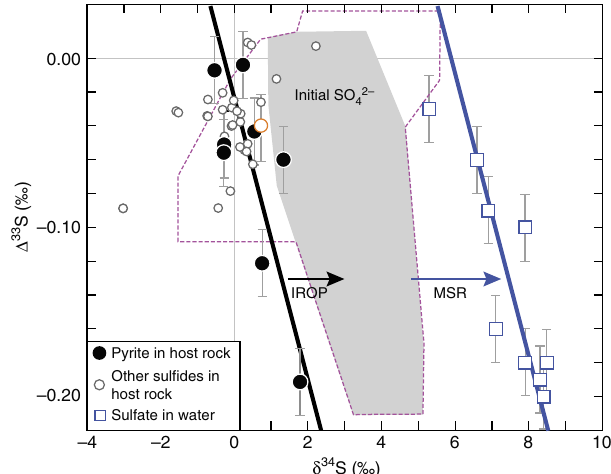
Figure 3 | Comparison of d 34 S and D 33 S between dissolved sulfate and host-rock sulfides. Error bars (if not shown, smaller than the symbols) are 1 s uncertainty. Dissolved sulfate in drilling water (open orange circle) is also plotted for comparison. The black solid line represents mixing between pyrite minerals with different sulfur isotope compositions 15 and the blue solid line represents mixing between dissolved sulfate in the fracture waters, respectively. Based on the estimated 1.5 % to 3.4 % enrichment 36 in d 34 S in the product sulfate during the indirect radiolytic oxidation of pyrite (IROP), the initial isotopic compositions of product sulfate are shown as the area in grey (for pyrite only), or the area defined by the dashed magenta lines (for all sulfides). Significantly, d 34 S values for dissolved sulfate in the fracture water are instead B 6 % more enriched in 34 S than pyrite, suggesting that an additional process of isotopic enrichment, possibly microbial sulfate reduction (MSR), has affected the measured sulfate (see